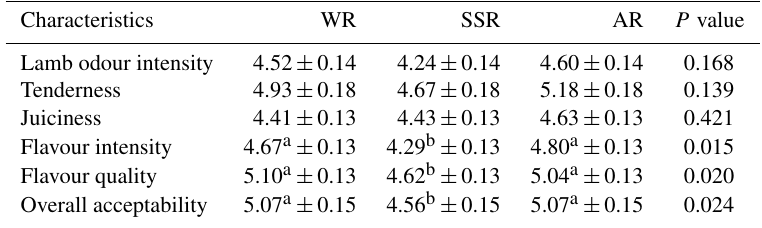
Table 6. Means ± SE for meat sensory characteristics of lambs reared in different seasons. Characteristics